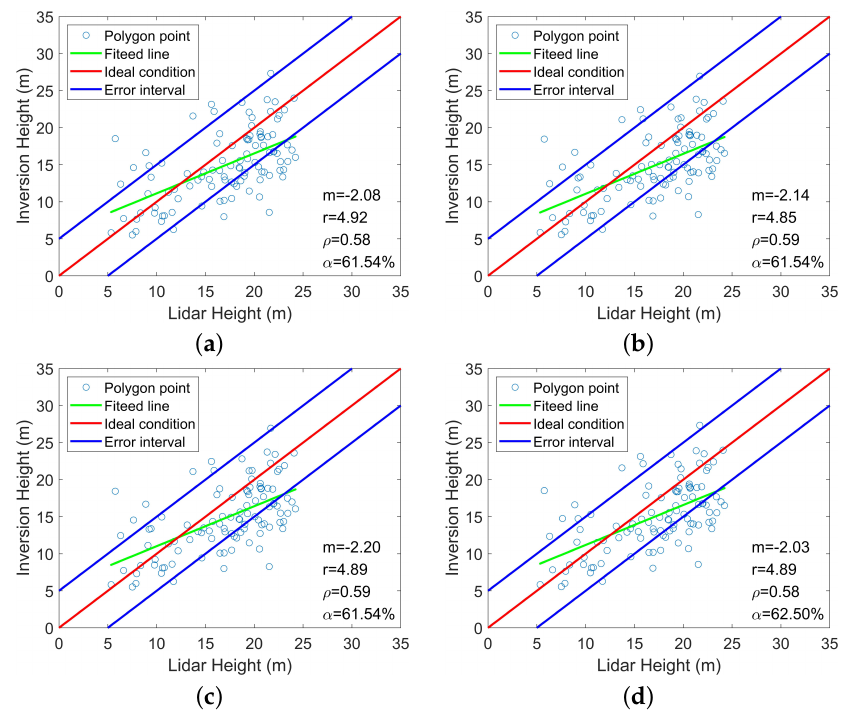
Figure 10. The correlation plots of P-band in different configurations. ( a ) TSIA + EBCR + LUT. ( b ) TSIA + IEBCR + ILUT. ( c ) TSIA + EBCR + ILUT. ( d ) TSIA + IEBCR +